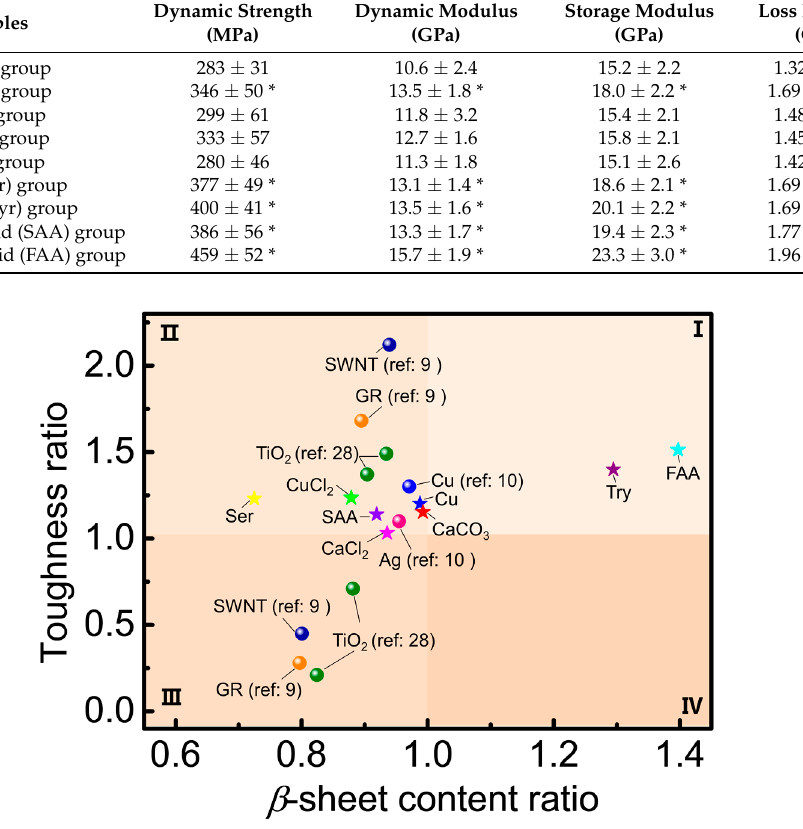
Figure 6. The relation of β -sheet content ratio and toughness ratio of silk fibers between modified and control group.